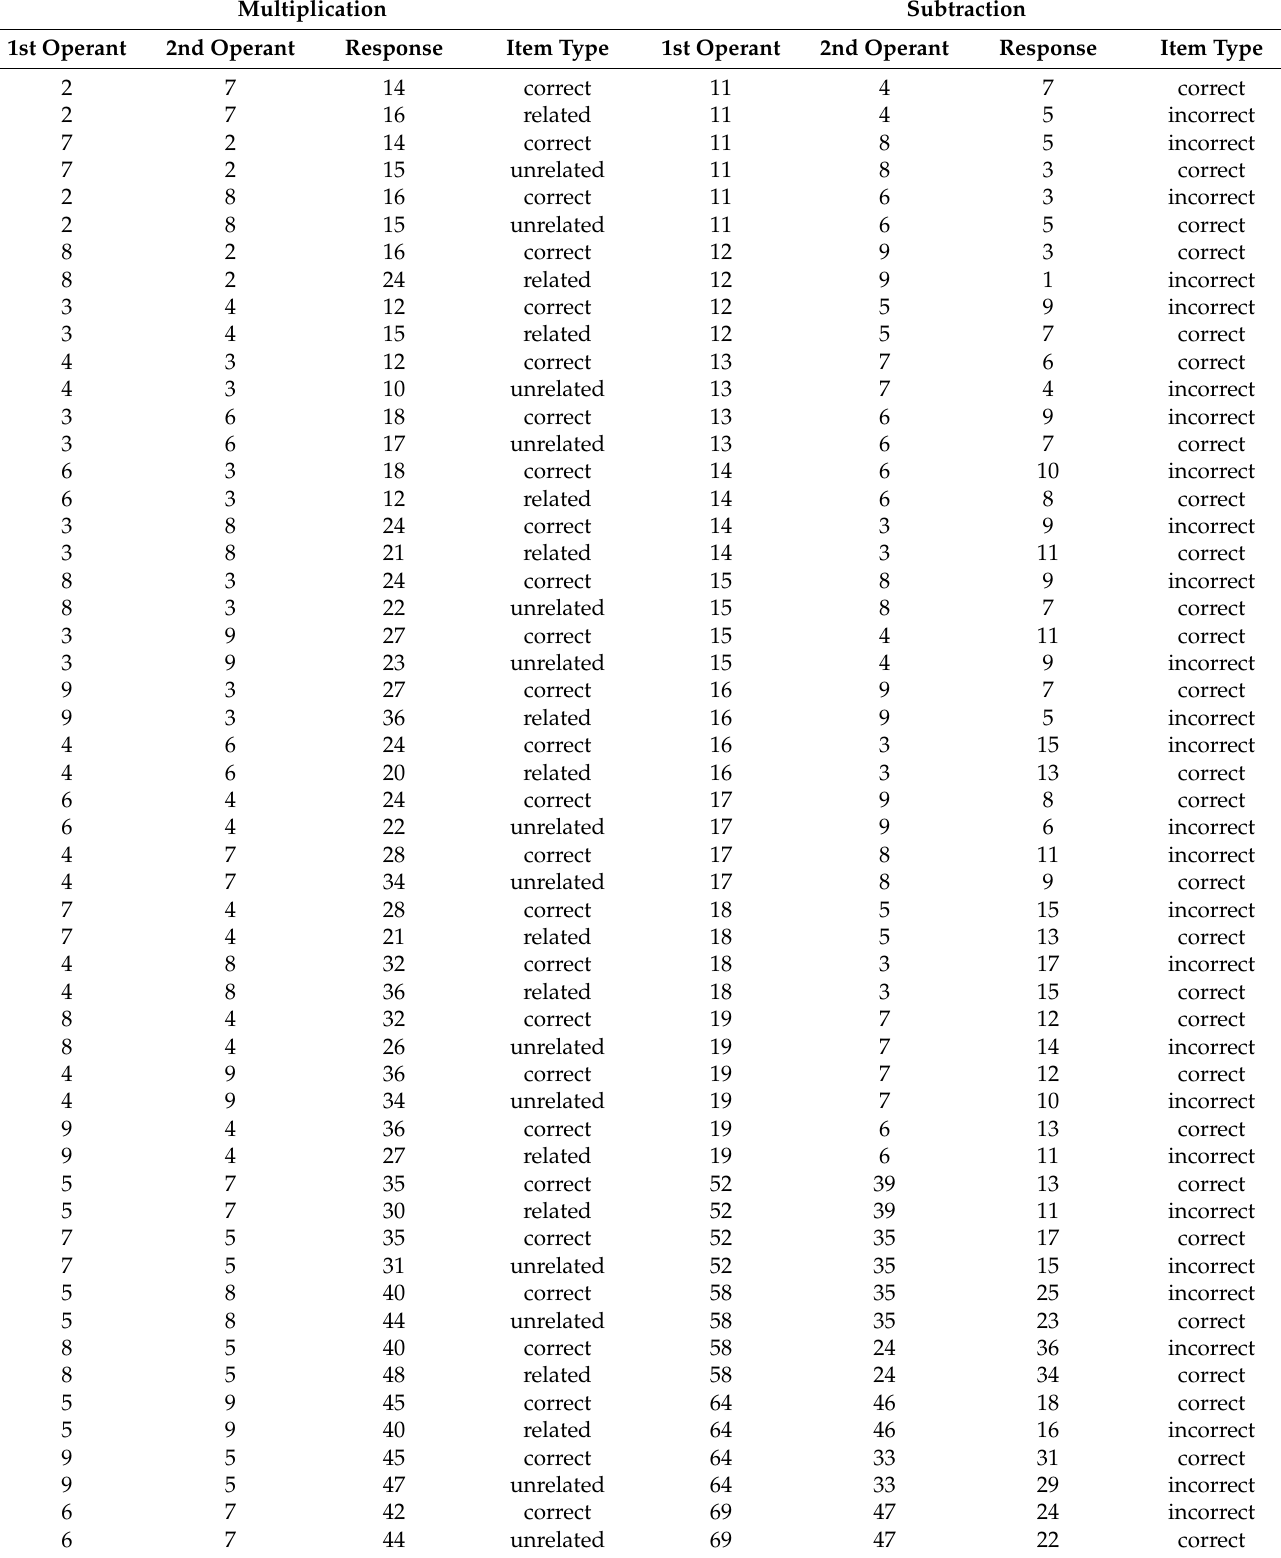
Table A1. Items for the arithmetic tasks in the fMRI